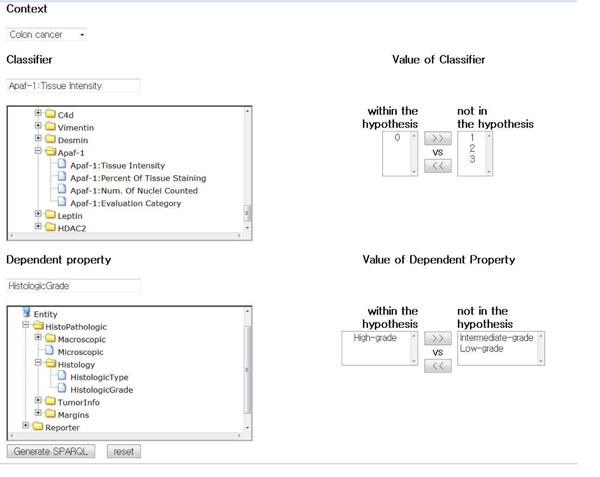
Web interface to generate SPARQLs by selecting factors and their value sets